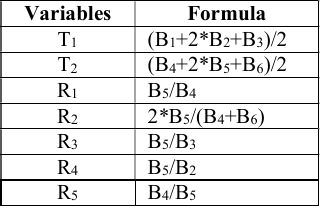
Figure 3. List of variables that support better description of a shape of a spectral pattern. B 1 --- B 3 denote TOA reflectance for bands blue, green, red, near infrared, short infrared 1and shortwave infrared 2